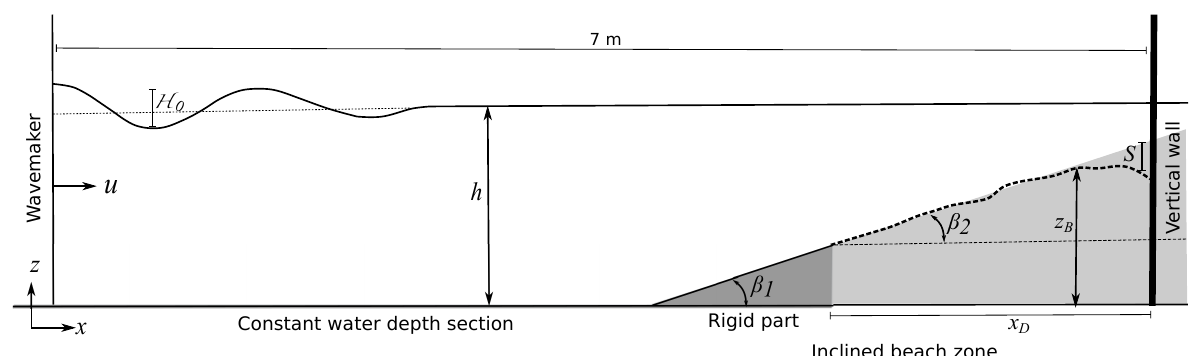
Figure 2. The schematic of the wave flume used for the experimental and numerical modelling of sediment scouring due to non-breaking waves on a vertical wall. The figure is not to scale.